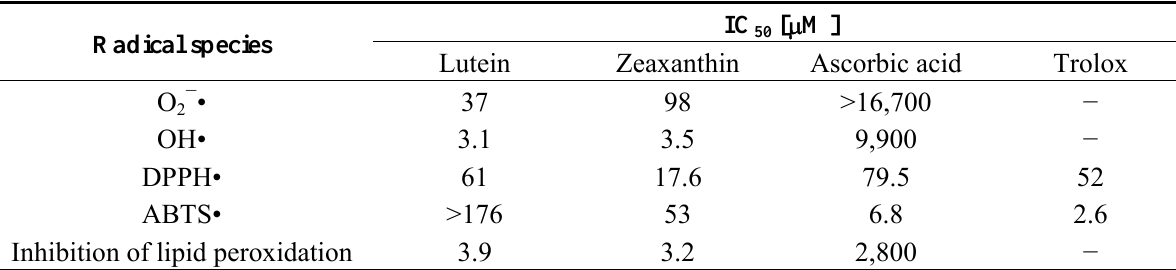
Table 1. IC values of some carotenoids, ascorbic acid, and Trolox against various ROS 50 species and organic